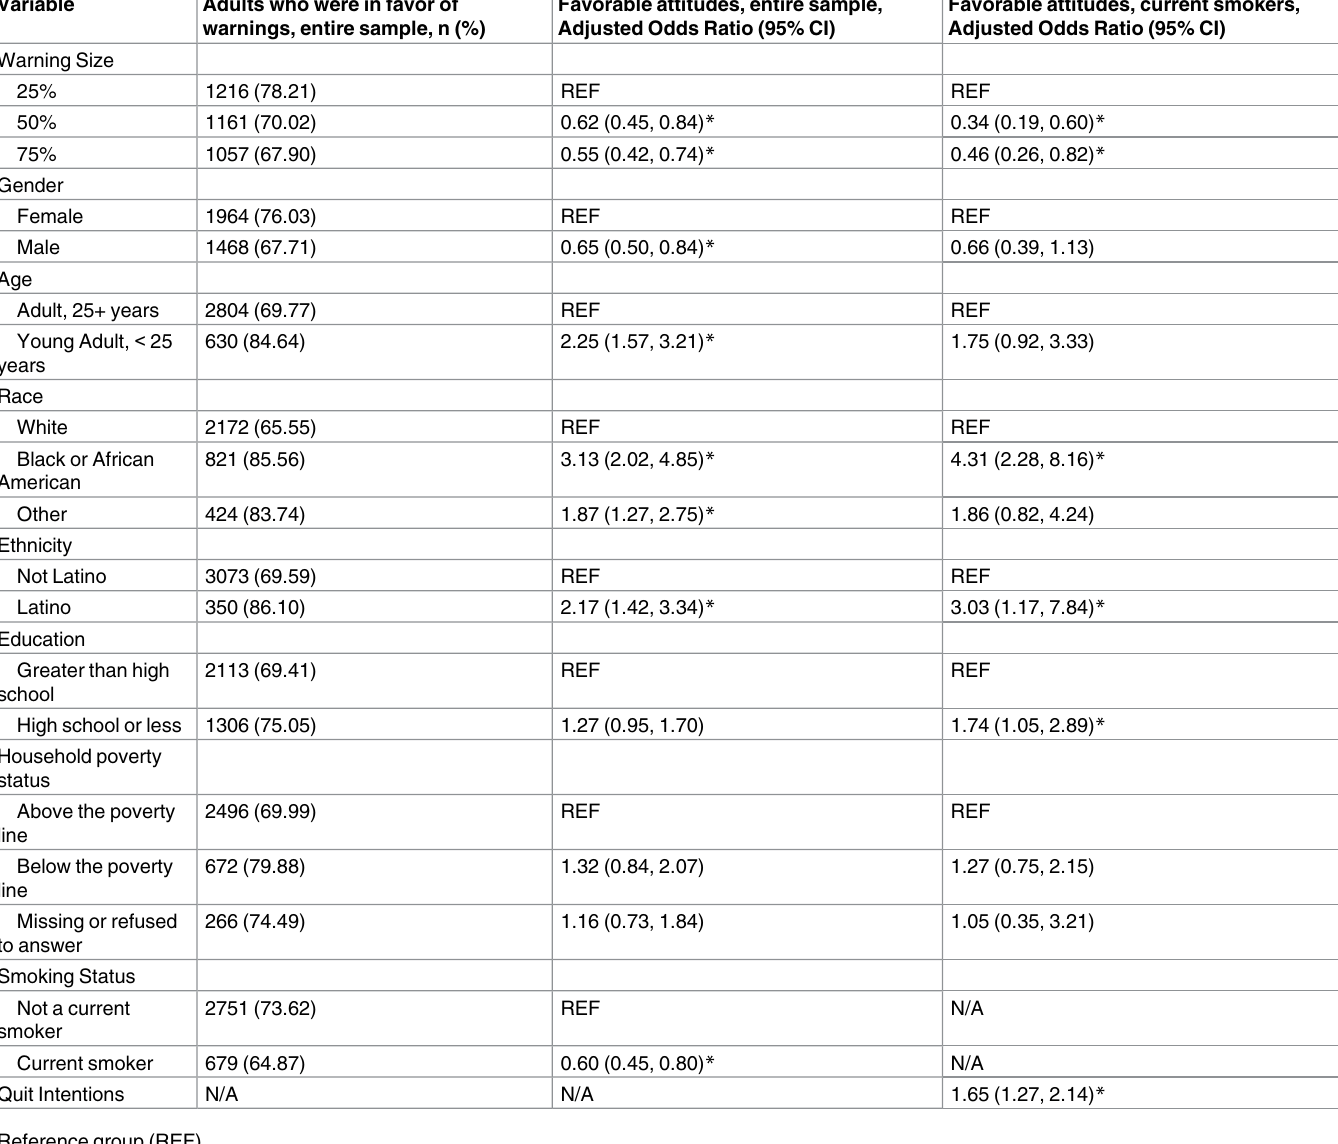
Table 2. Weighted logistic regression results, for the entire sample and current smokersonly.